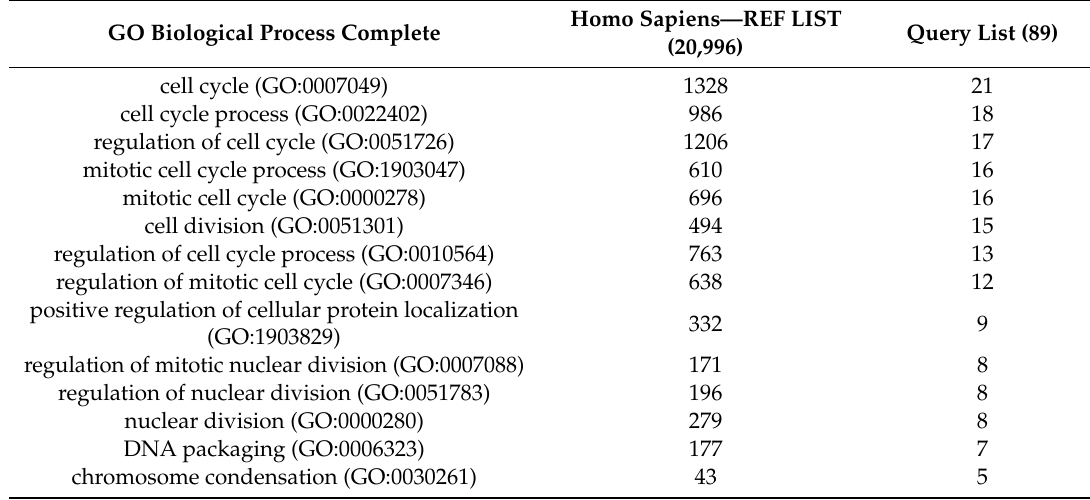
Table 8. Gene ontology analysis of shortlisted genes by biological